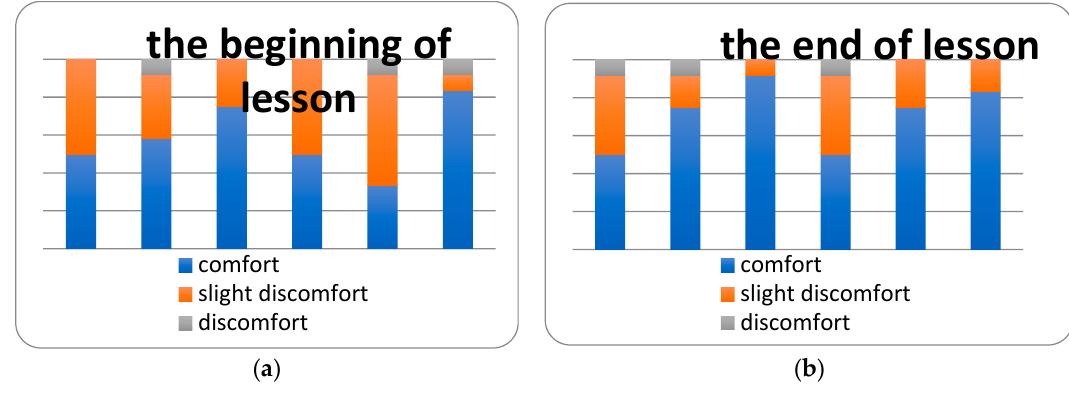
Figure 13. Sensory evaluation. ( a ) Evaluation at the beginning of the lesson; ( b ) Evaluation at the end of the lesson.